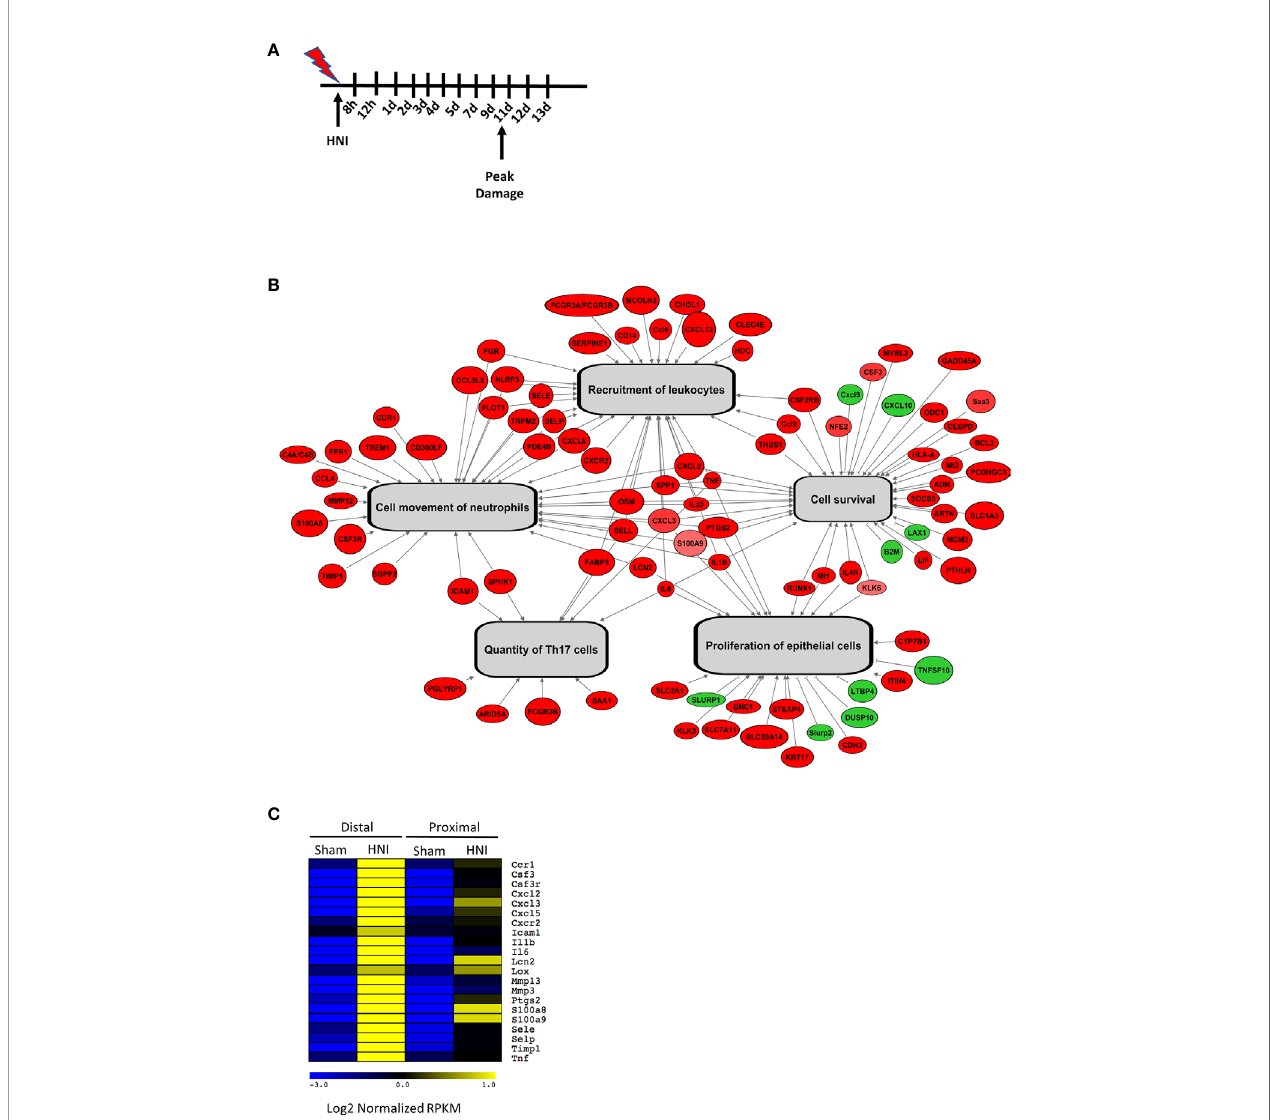
FIGURE 1 | Targeted HNI induces OM in mice. (A) Model of HNI-induced OM. Mice received no radiation (sham) or HNI on D0, and tongues were harvested at various time points. (B) Schematic analysis of select biological functions predicted to be activated in response to HNI. Genes colored in red have HNI-induced expression and genes labeled in green have HNI-repressed expression. Gray arrows depict biological functions that are predicted by our analysis to be activated. (C) Comparison of IL-17RA regulated genes between sham and irradiated mice in the distal portion of the